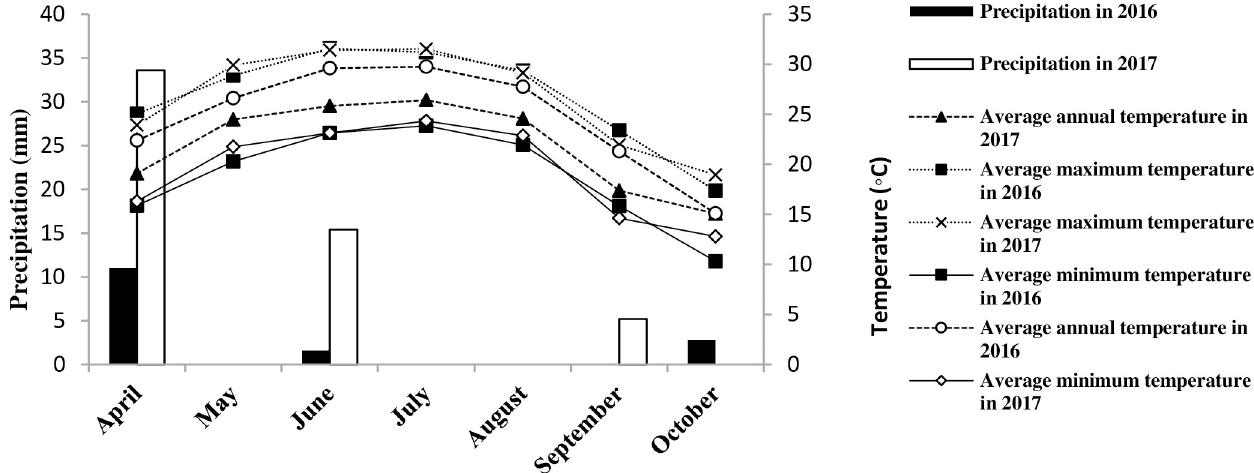
Fig 1. Daily temperature (˚C) and precipitation (mm) records during two growing seasons (2016 and 2017).